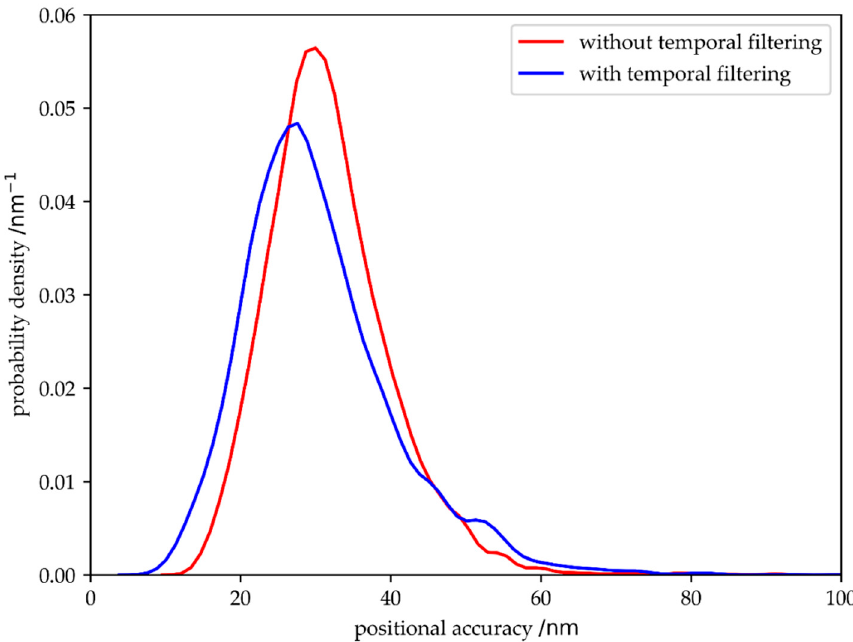
Figure 8. Comparison of the positional accuracy obtained for single molecule signals with (blue) and without (red) temporal filtering. Data include simulations with varied parameters for B, τ on , τ off and ω T . Data were analyzed with the algorithm by Gao et al. [23].